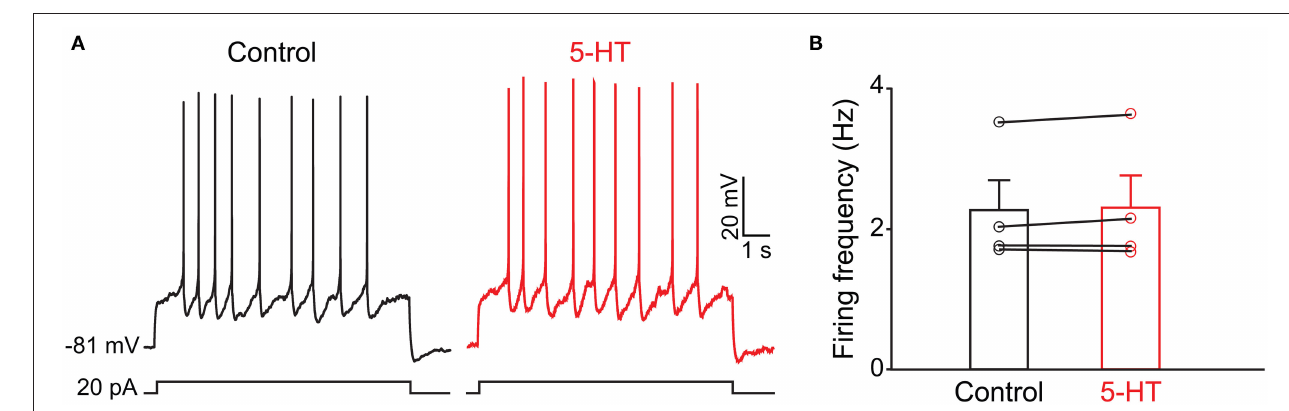
FIGURE 4 | The activity of PPG neurons is not modulated by serotonin (5-HT) (A) Representative current-clamp recording elicited by injecting a perithreshold current of 25pA with a pulse duration of 5s in 18s intervals. A baseline recording of 15min was acquired before switching to bath application of 5-HT for an additional 30min. (B) Bar/scatter plot of the mean AP firing frequency under baseline then 5-HT stimulation conditions in 4 cells, not significantly different, paired t -test, p > 0.05.